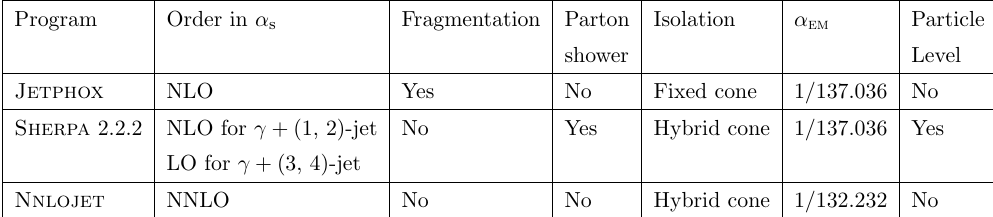
Table 2 . Major features of the three predictions used for inclusive isolated-photon